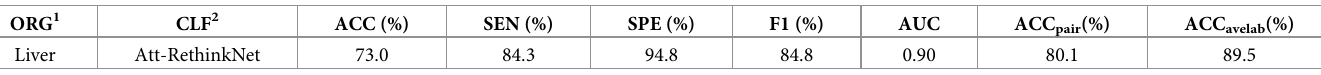
Table 13. Classification results on the liver in vitro data set.